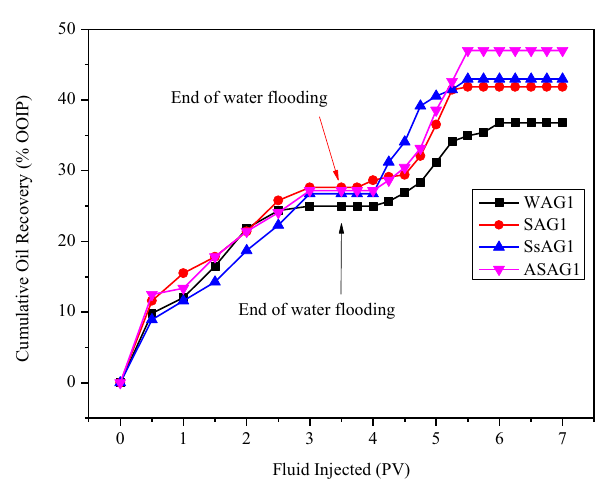
Fig. 5 Oil recovery performance of core flooding experiments done on low porosity–permeability core